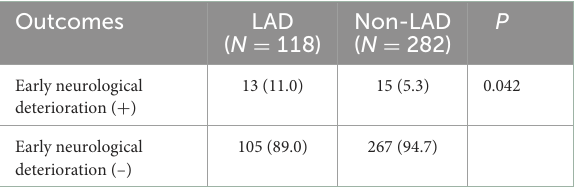
TABLE 3 Correlation between large artery disease and early neurological deterioration in intravenous alteplase (–)